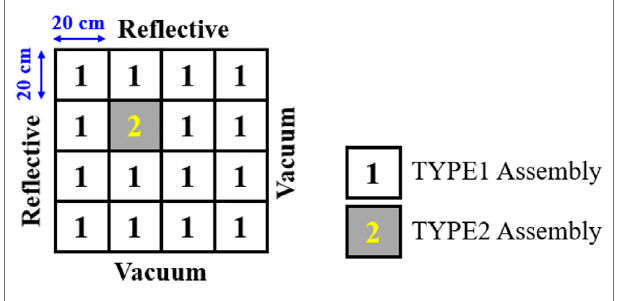
FIGURE 4 | One-group reactor problem.